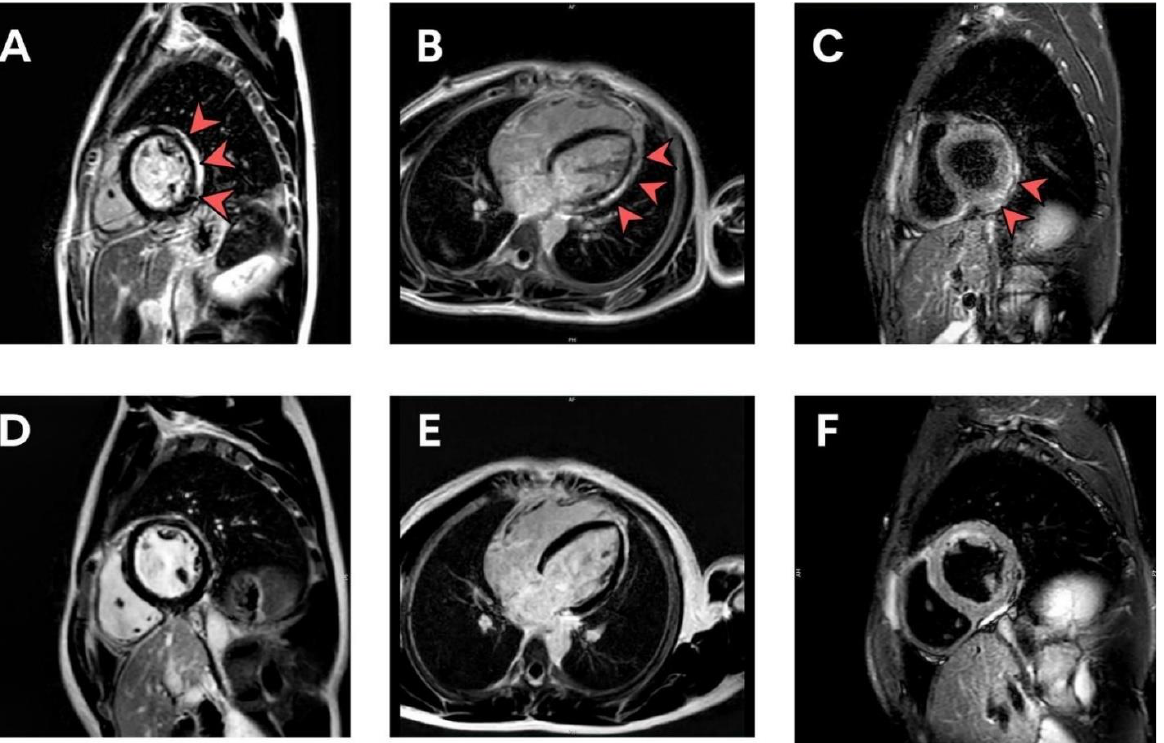
Figure 2. ( A – F ) cMRI illustrating LGE in a patient with subacute myopericarditis at the time of diagnosis ( A – C ) and 5 months post-diagnosis ( D – F ). cMRI, cardiac magnetic resonance imaging; LGE, late gadolinium enhancement. Table 2. Presentation with myopericarditis, subclinical myocarditis, and pericarditis after second dose vaccination.